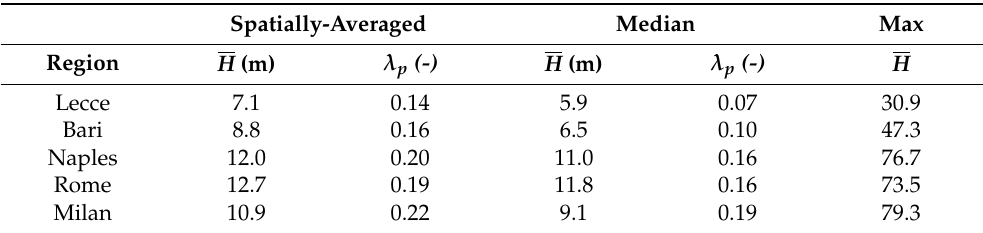
Table 1. Spatially-averaged, median and maximum values of the morphological parameters over the whole region. Spatially-Averaged